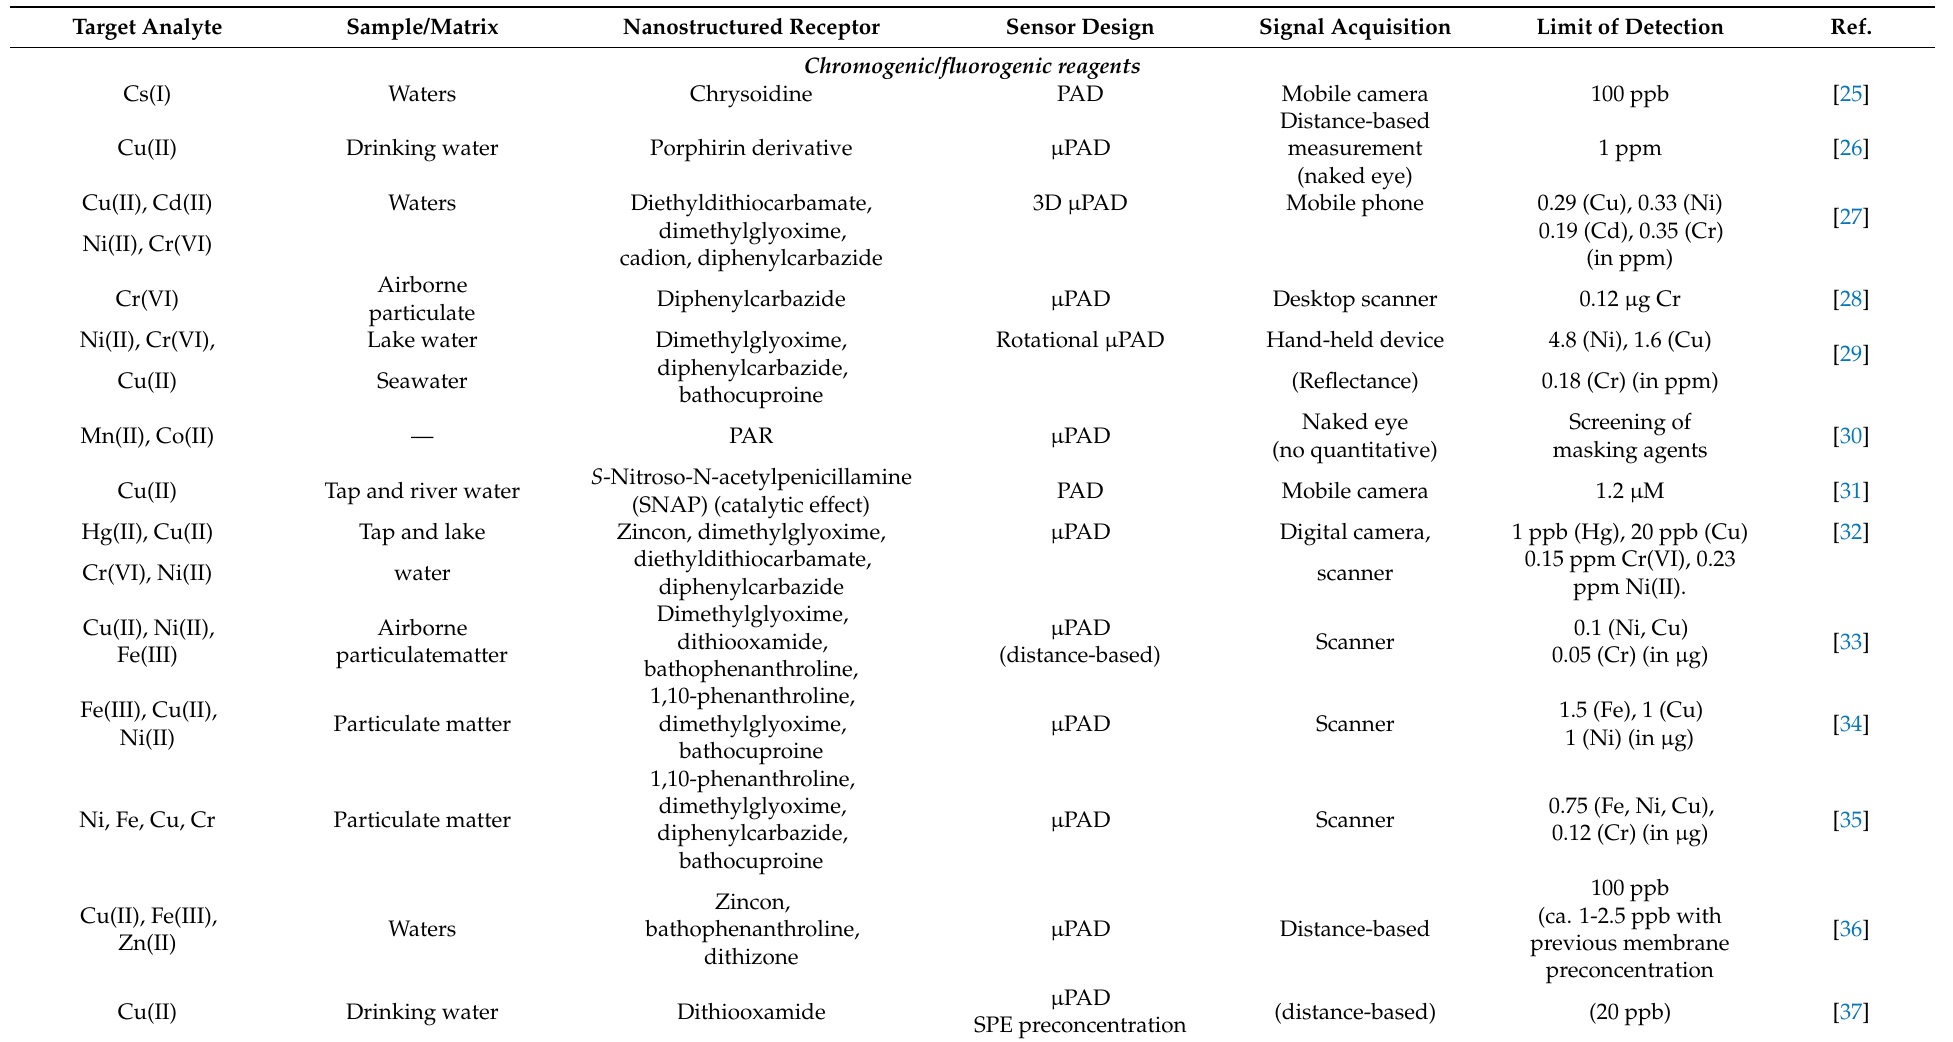
Table 1. Applications of colorimetric detection of metal ions using PADs and µ PADs along with chromogenic/fluorogenic and nanostructured